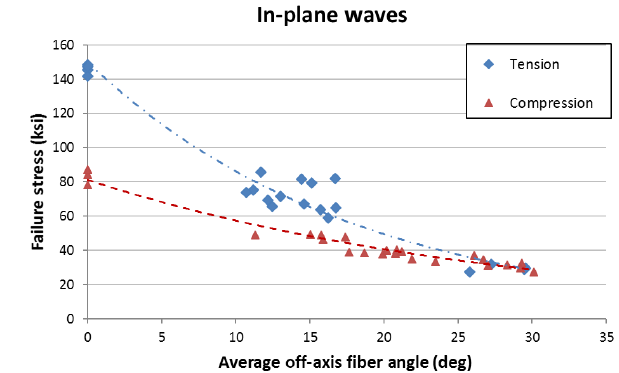
Figure 1. Individual and trending failure stress for each average off-axis fiber angle